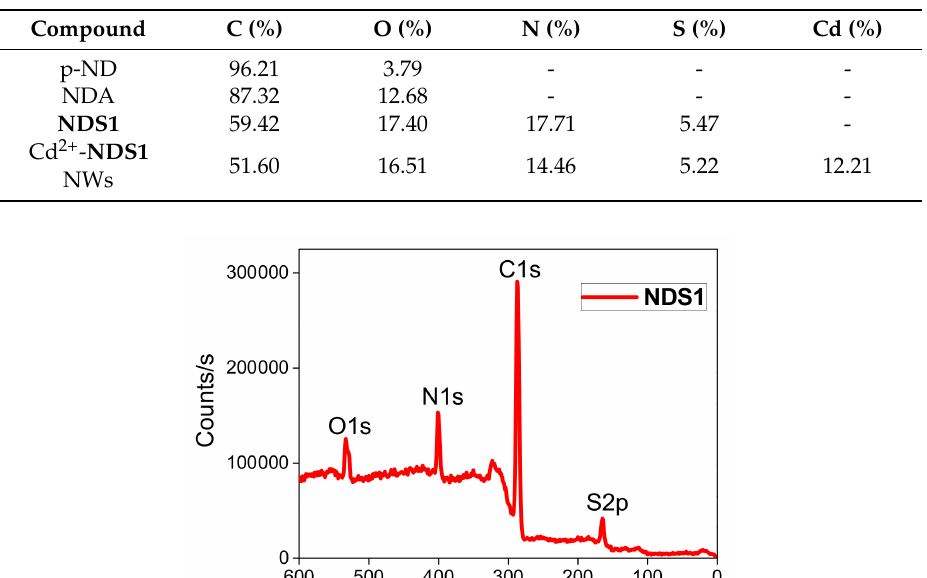
Table 1. EDX data of ND derivatives and Cd 2+ - NDS1 NWs.